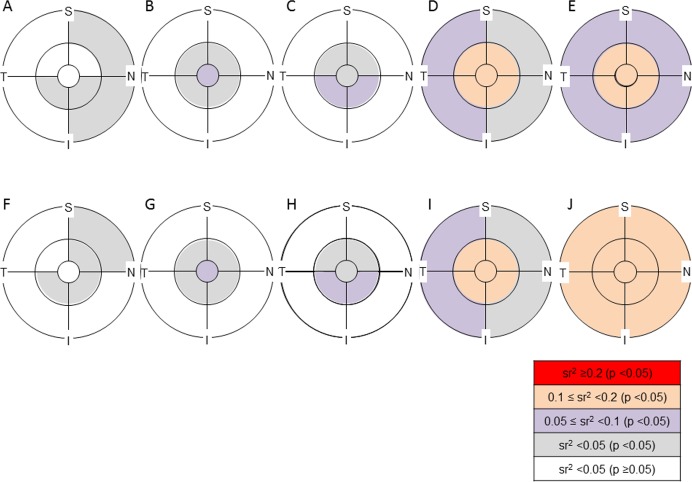
Semipartial correlation of gender with the thickness of retinal layers in each analytical area with or without magnification correction.The significance of the semipartial correlation coefficient (sr) and magnitude of the sr squared (sr2) are color coded in each analytical area. S = superior, N = nasal, I = inferior, T = temporal. A, F: retinal nerve fiber layer, B, G: ganglion cell layer plus inner plexiform layer, C, H: ganglion cell complex, D, I: total retina, E, J: outer retina. A—E: ‘magnification-uncorrected’ analytical area, F—J: ‘magnification-corrected’ analytical area. A significant sr was found in the inner ring of inner retinal layers and in all the analytical areas of outer and total retina. The sr2 was relatively large in total and outer retina compared to inner retinal layers. The magnification correction of analytical areas did not cause remarkable changes in the magnitude of sr2 values compared to the sr of axial length with the thickness of retinal layers (Fig 6).